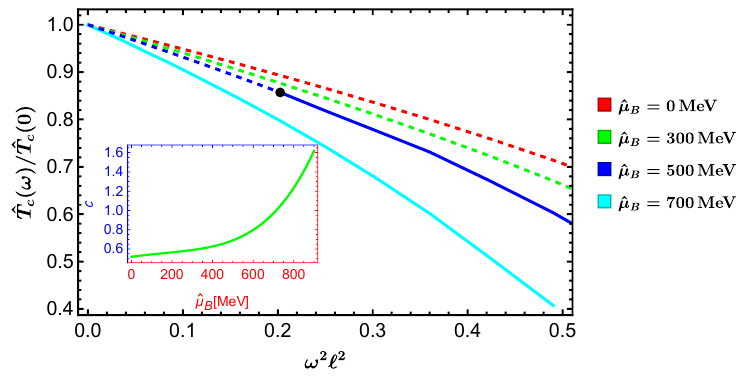
Figure 7 . The critical temperature ˆ T c as a function of ω for different ˆ µ B . For small ω , ˆ T c ( ω ) / ˆ T c (0) ≈ 1 − c ω 2 where the constant c increases as ˆ µ B is increased (see the Insert).